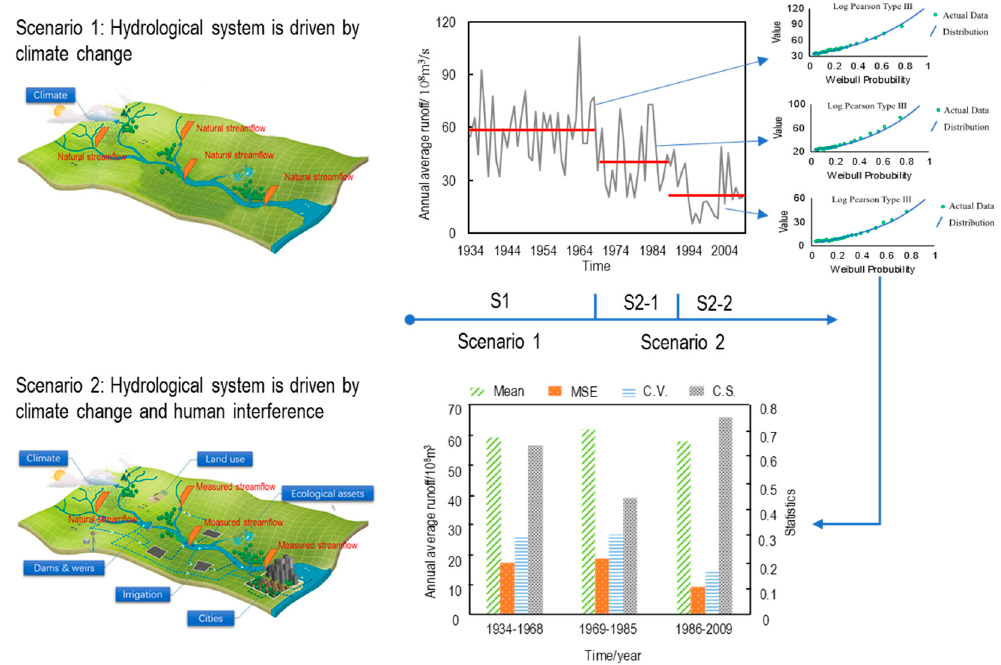
Figure 1. Step-changed runoff series and environment scenarios. In Figure 1, the Mean represents the mean value of each segment, MSE is the mean square error, C.V. is the coefficient of variation, and C.S. presents the deviation coefficient of each segment.